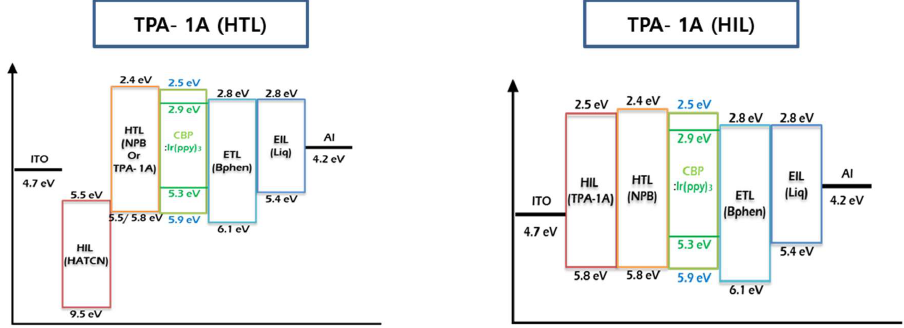
Figure 4. Energy diagram and device structure of TPA-1A-based Organic light emitting (OLED) devices.